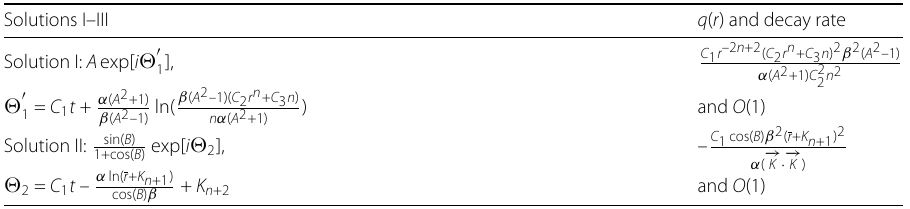
Table 2 Variable separation solution, inhomogeneity terms, and decay rate of equivalent ILLG equation (27) Solutions